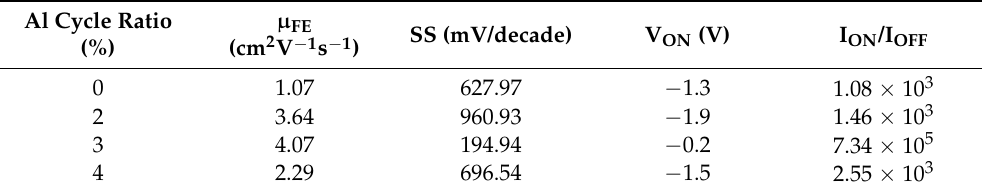
Figure 9. I D –V G curves of ZnO TFTs. ZnO and AZO films are used as the S/D electrode. Table 2. Electrical parameters of ZnO TFTs. Al cycle ratios of AZO S/D electrodes are 0%, 2%, 3%, and 4%, respectively.